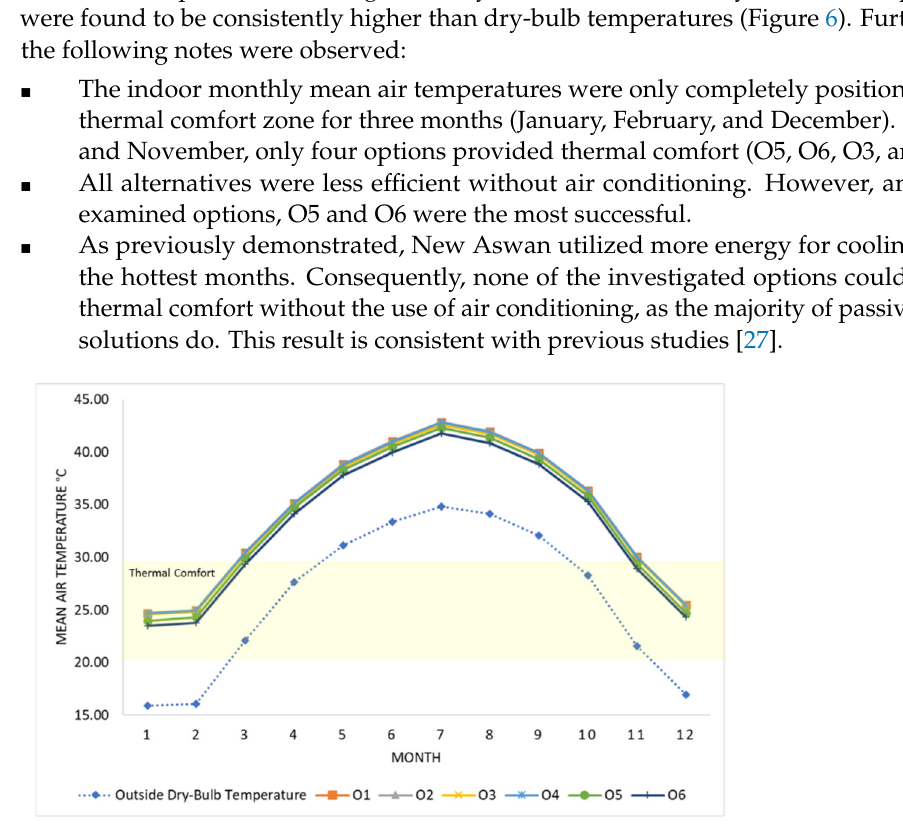
Figure 6. The monthly mean air temperature in the salon in terms of internal thermal conditions without using air conditioners.